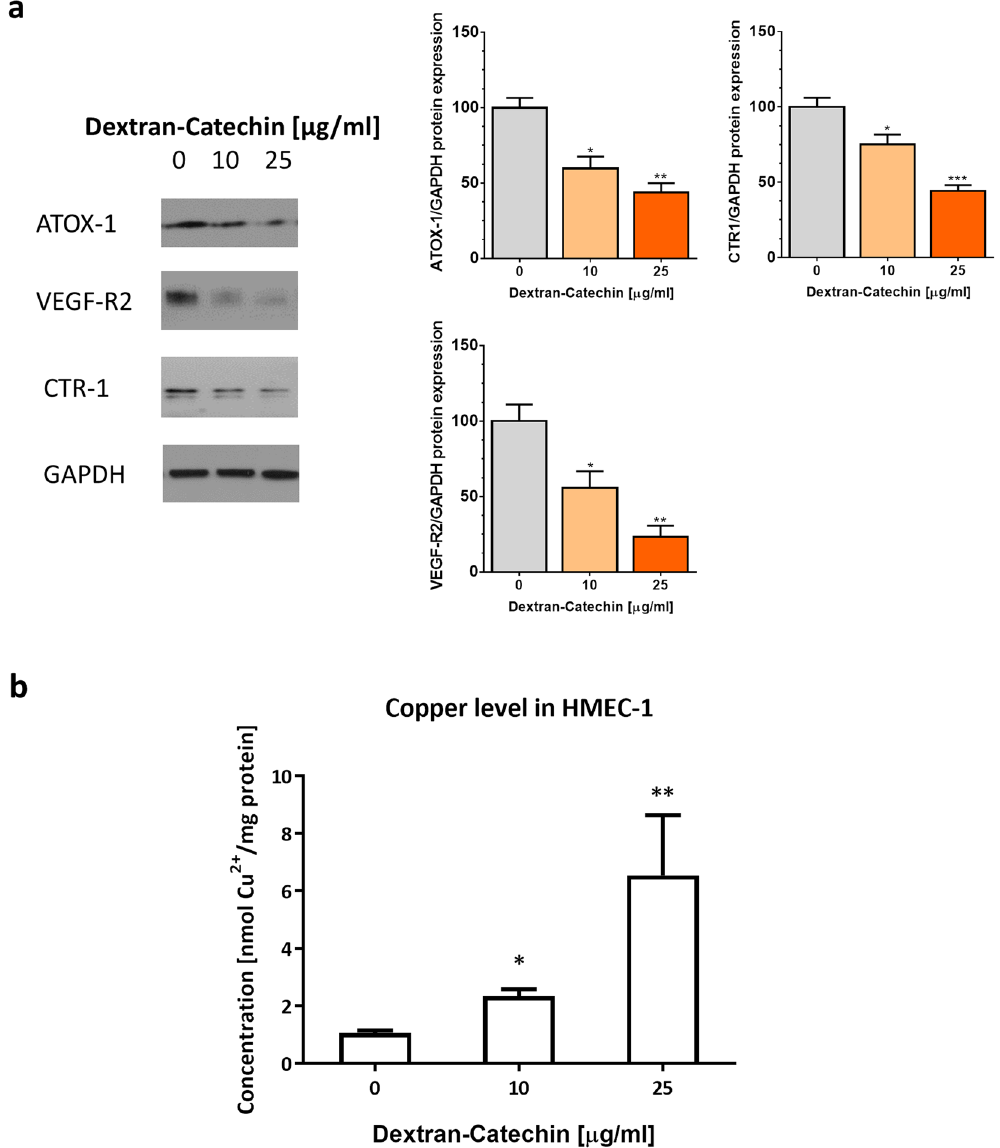
Figure 4. Levels of ATOX-1, VEGF-R2, and CTR-1 proteins and intracellular copper level in HMEC-1 cells following 24 h Dextran-Catechin treatment. ( a ) Representative western blot for ATOX-1 (7 kDa cropped band), VEGF-R2 (230 kDa cropped band), and CTR-1 (35 kDa cropped band) protein on whole-cell extracts from HMEC-1 cells. GAPDH (37 kDa cropped band) expression was used as a protein loading control. ( b ) Intracellular copper levels are higher in HMEC-1 cells with Dextran-Catechin treatment after 24 h compared to the control. Columns , n = 3; Bars , SEM ( * P < 0.01, ** P <